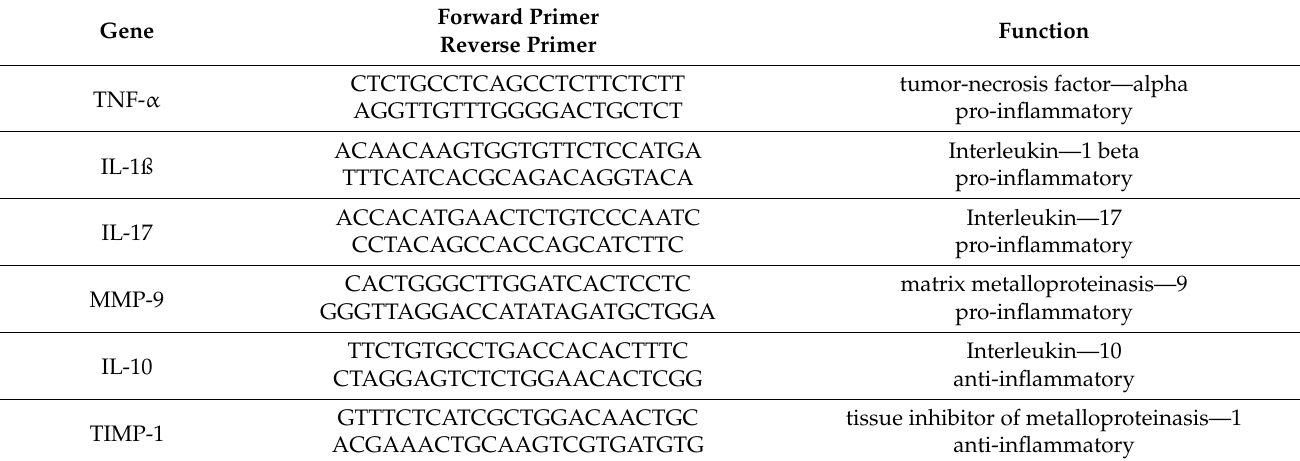
Table 2. Gene specific primer sets used in qPCR mRNA